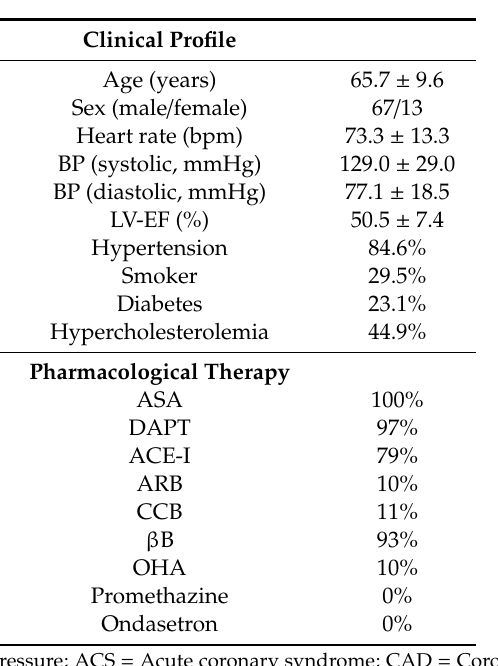
Table 1. Patients’